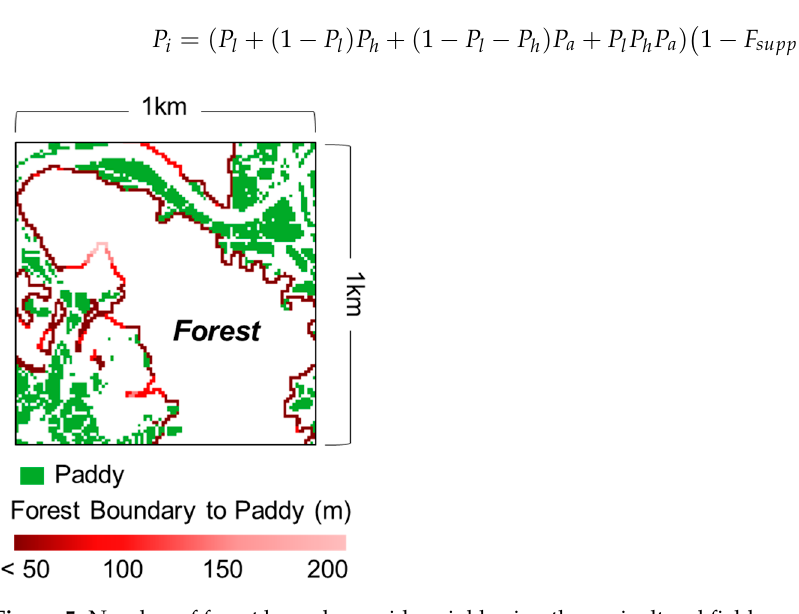
Figure 5. Number of forest boundary grids neighboring the agricultural field.